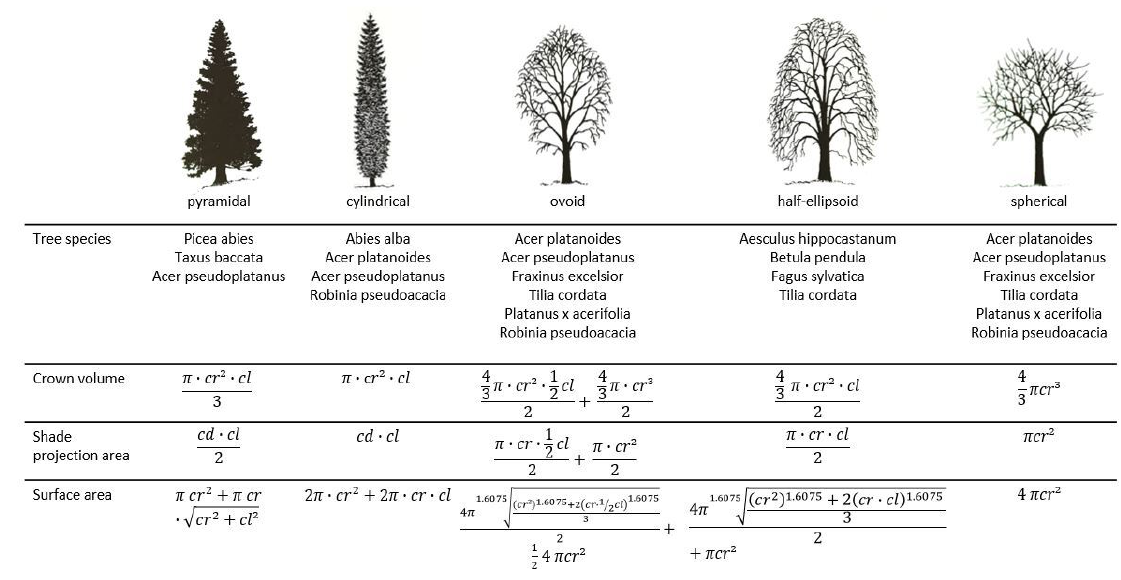
Figure 2. Mathematical equations for the calculation of crown volume, crown shade projection area and surface area for different crown shapes. Crown shapes illustrations from Lawrence, 1985 (Abbreviations as in text and cd— 2 ·